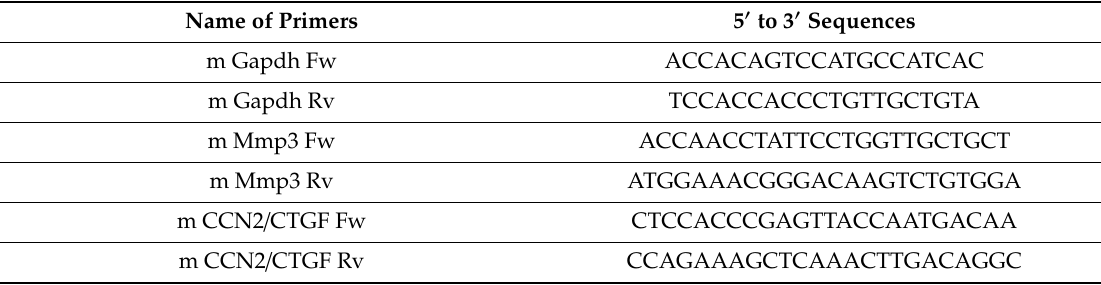
Table 7. The sequence of primers for